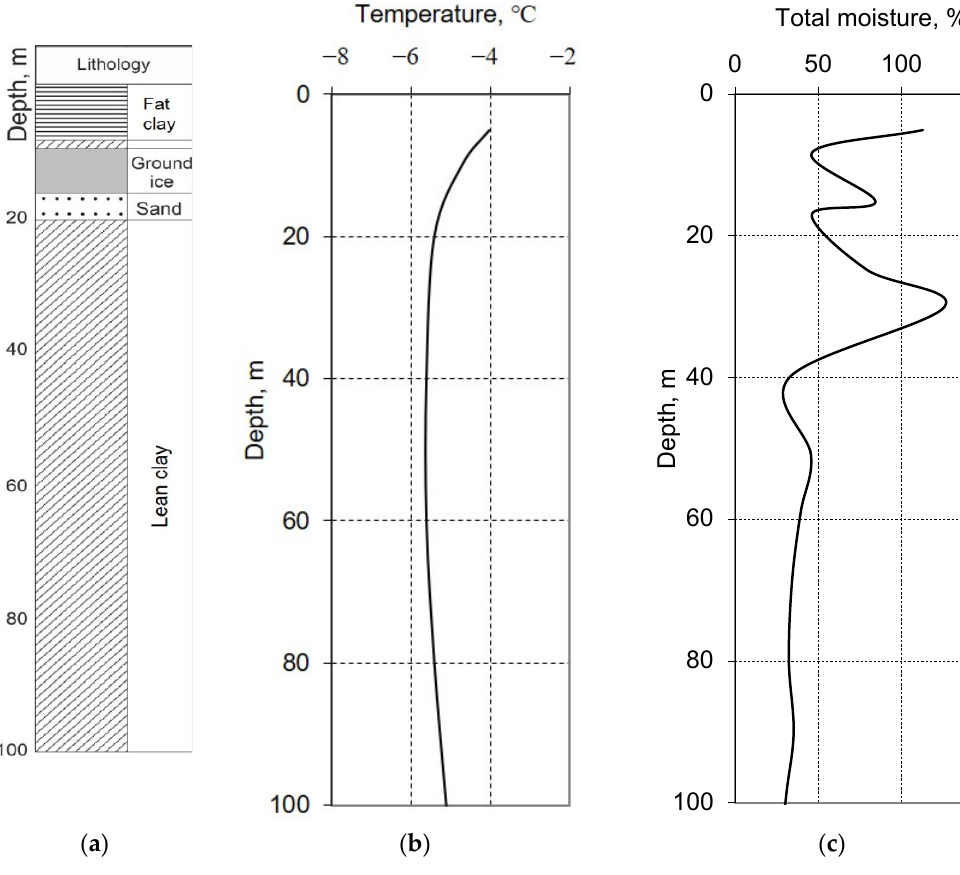
Figure 7. Depth profiles (to 100 m) of permafrost type ( a ), temperature ( b ), total moisture ( c ), salinity ( d ), and organic carbon content ( e ) estimated from log data for the area of the Bovanenkovo gas field in the Yamal Peninsula [87].